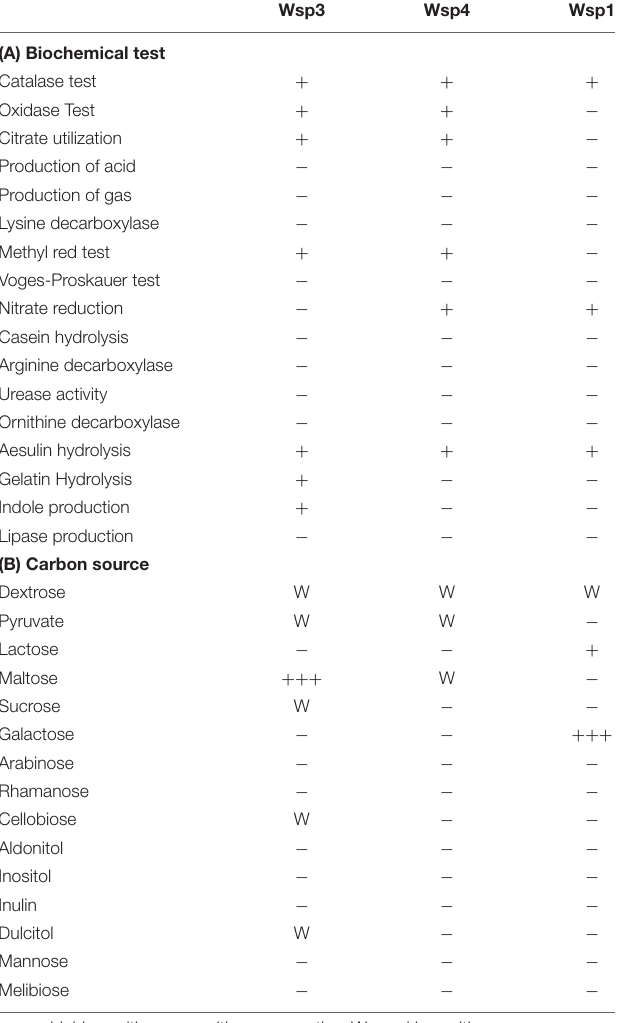
TABLE 1 | (A) Biochemical test and (B) carbon source utilization test as an aid to the classification of haloarchaea.